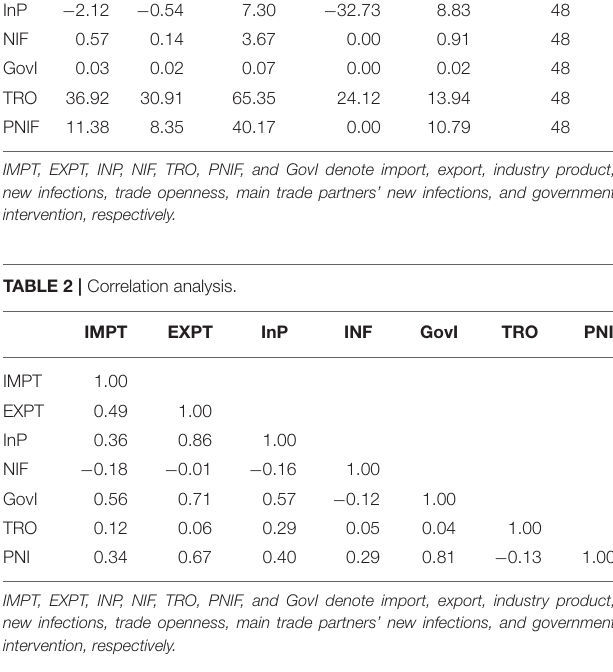
Table 2 provides the bivariate association between